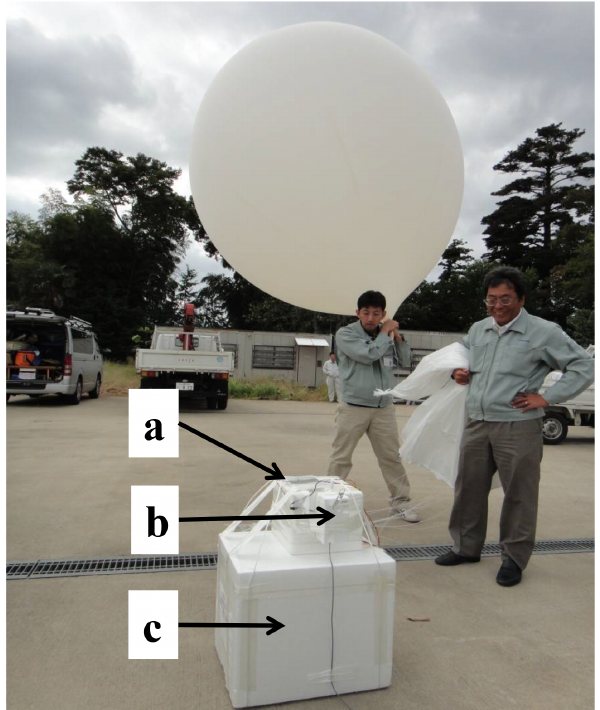
Figure 2. Photograph of the CO 2 sonde developed in this study before launching. (a) The CO 2 measurement package as shown in Fig. 1, (b) GPS sonde, and (c) calibration gas